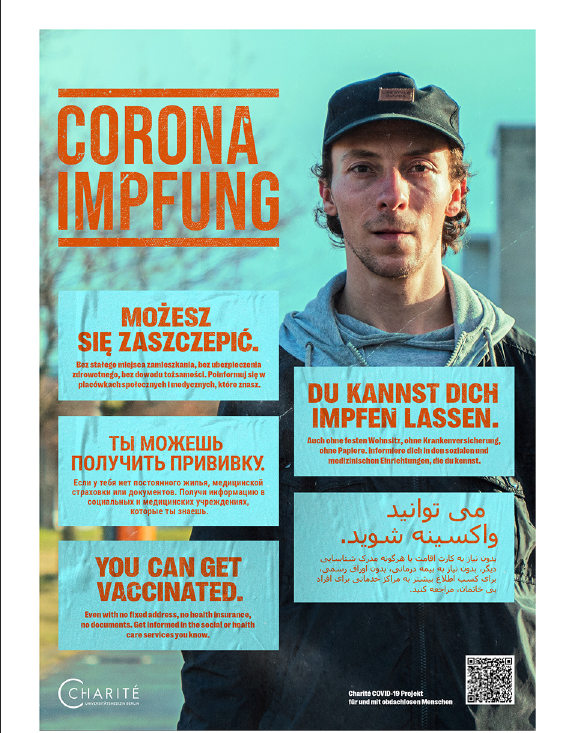
FIGURE2 Multilingual poster disseminated digitally and in print to support the public COVID-19 vaccination campaign for people experiencing homelessness (one out of seven different motifs).